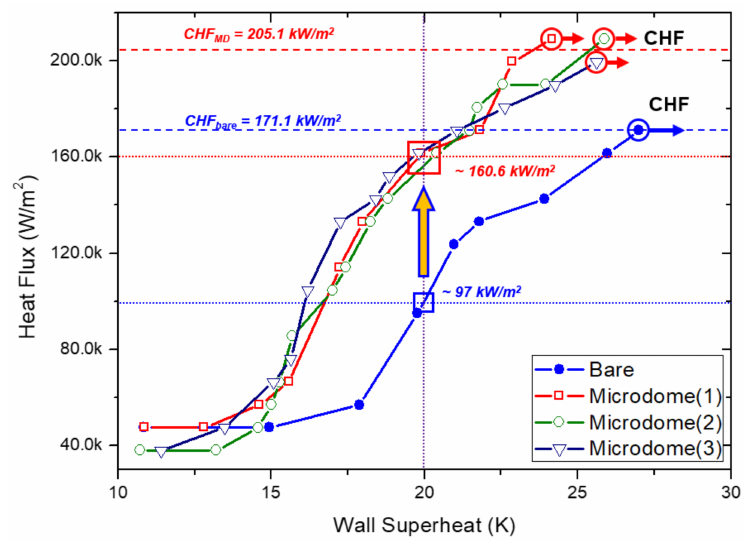
Figure 6. Comparison of the boiling curves of three DMF microdome Al substrates and a bare Al